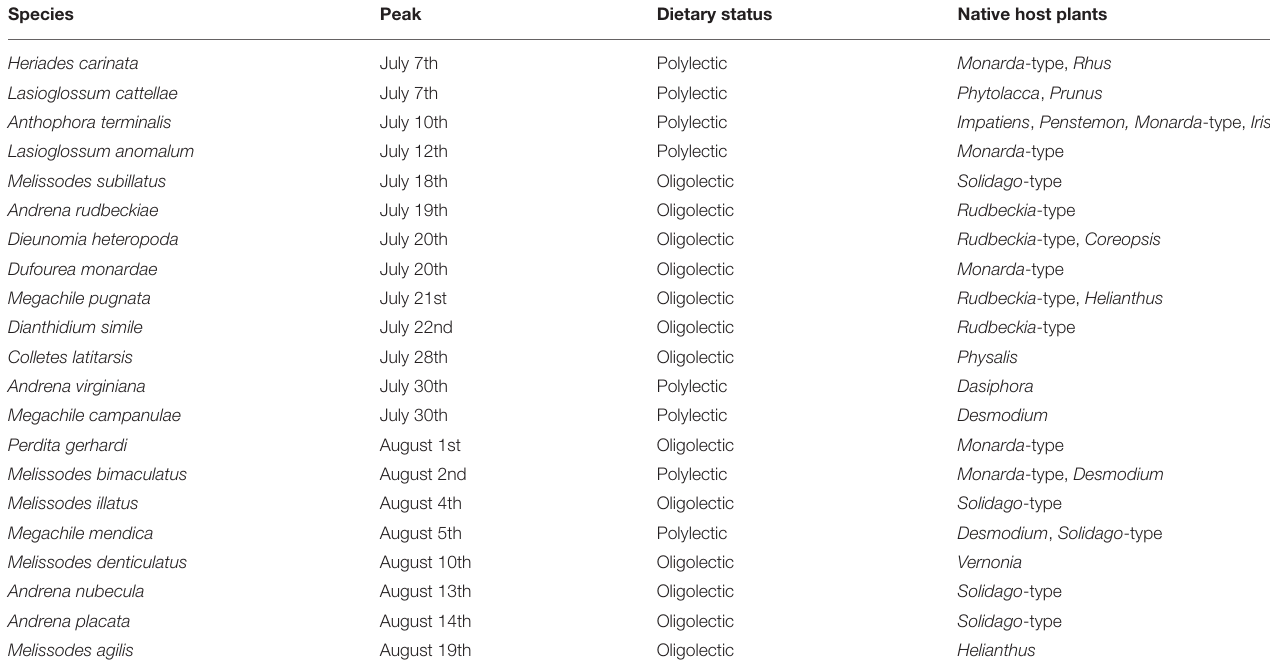
TABLE 3 | Solitary bee species that peak during the period of non-native pollen collection by honey bees (4 July − 21 August) and their pollen foraging preferences from native plant species recorded in Michigan (2006–2018).